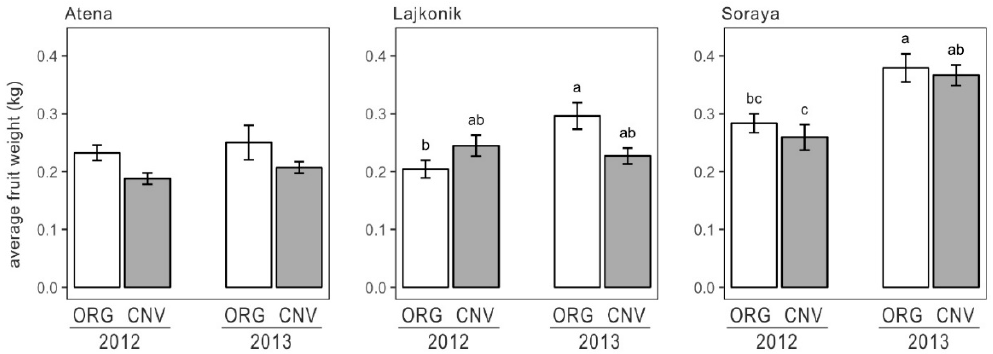
Figure 5. Average fruit weight of organic (ORG) and conventional (CNV) courgette of Atena, Lajkonik and Soraya cultivars grown in two consecutive years. Data are presented as means with standard errors. Within each cultivar, bars marked with the same letters are not significantly different at the 5% level of probability.